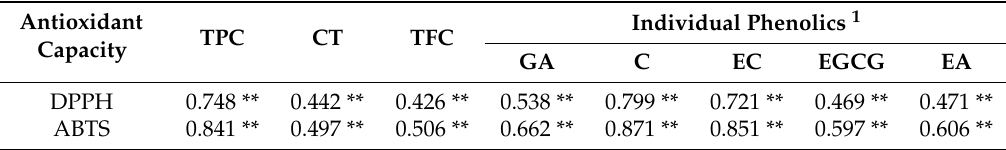
Table 2. The correlation between phenolics and antioxidant